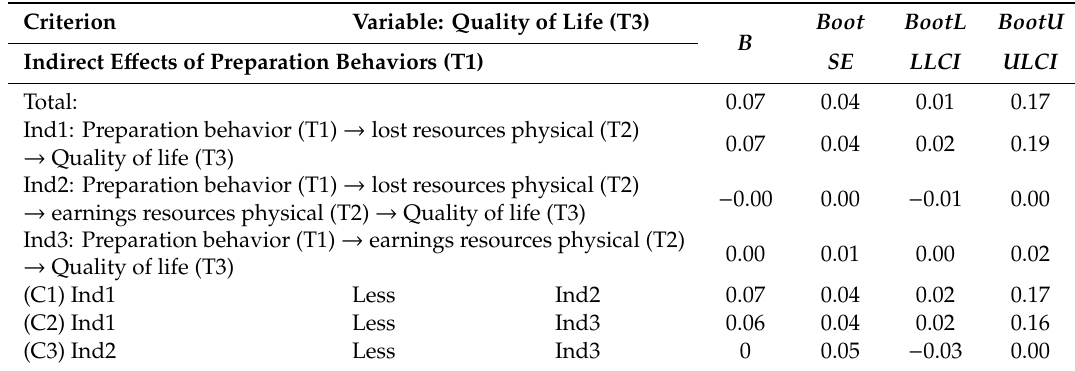
Table 2. Comparison of the indirect e ff ects of preparation behaviors (T1) through physical resource losses (T2) and gains (T2) in the prediction of quality of life